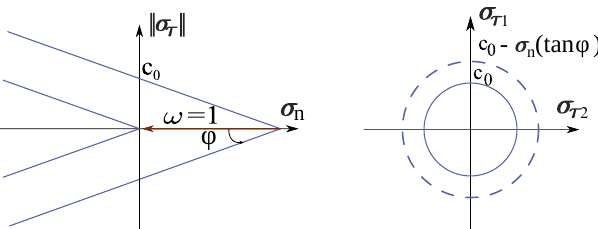
Figure 2. Illustration of the Mohr–Coulomb yield surface. As the damage parameter ω increases, the yield surface is shifted along the normal stress axis in negative direction.